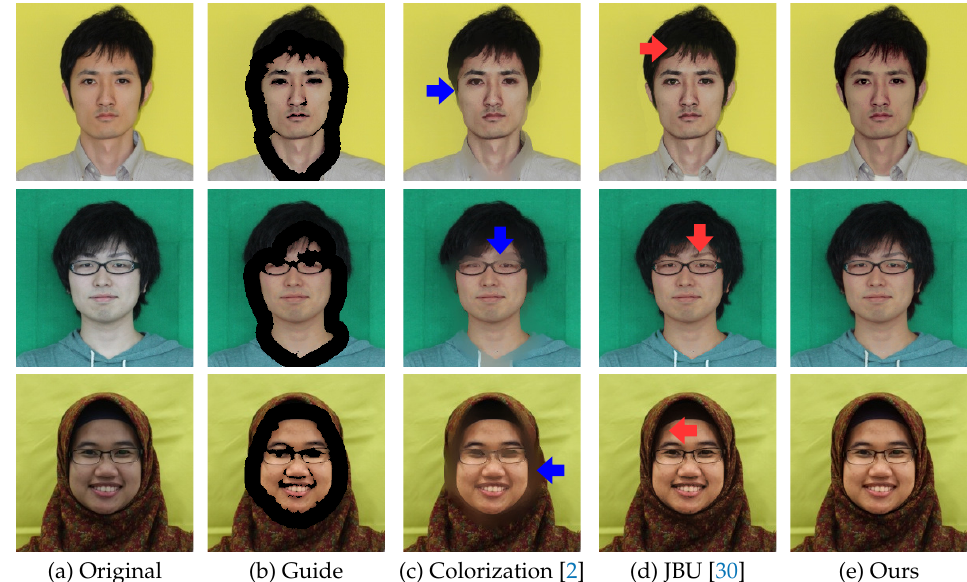
Figure 11. Supplement quality comparison with similar methods. ( a ) original; ( b ) guide; ( c ) coloriza- tion for each RGB layer [2]; ( d ) joint bilateral upsampling (JBU) for each RGB layer [30], and ( e ) our guided filtering (5). The black pixels in ( b ) represent a hole region, and each red arrow indicates an